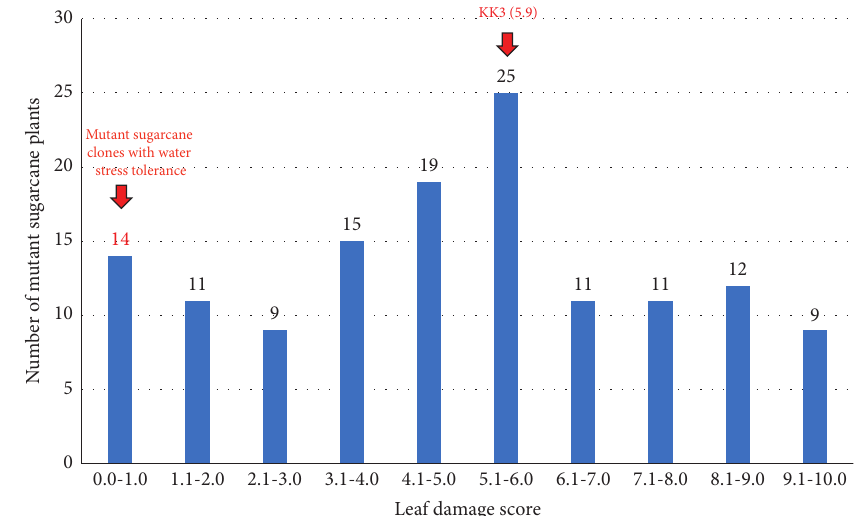
Figure 3: Leaf damage scores of mutant sugarcane clones after evaluation for water-stress tolerance in a